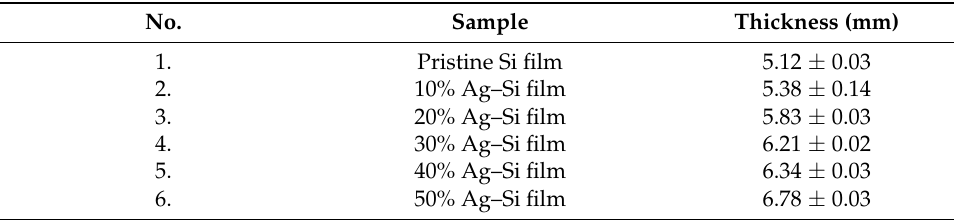
Table 1. List of samples and their film thickness.